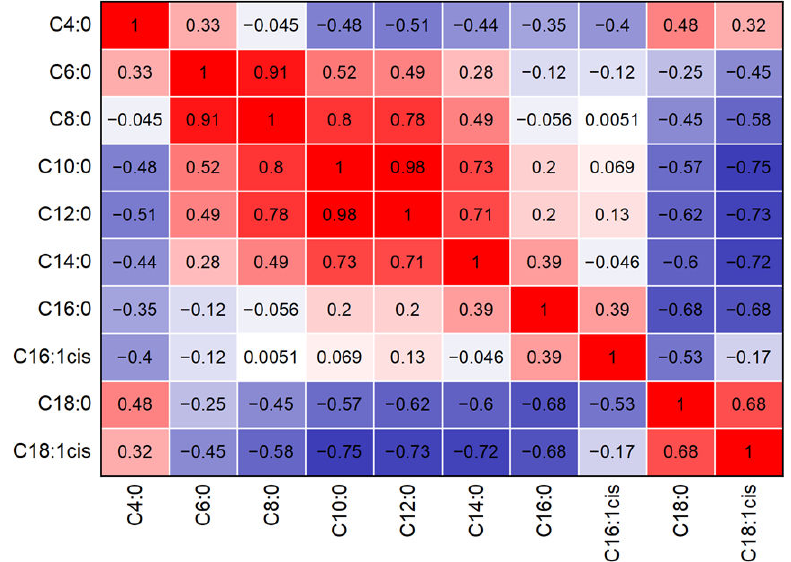
Figure 4. Cross-correlation matrix of pairwise correlations between individual fatty acids from GC/MS reference measurements. Red color indicates positive correlation, whereas blue color indicates negative